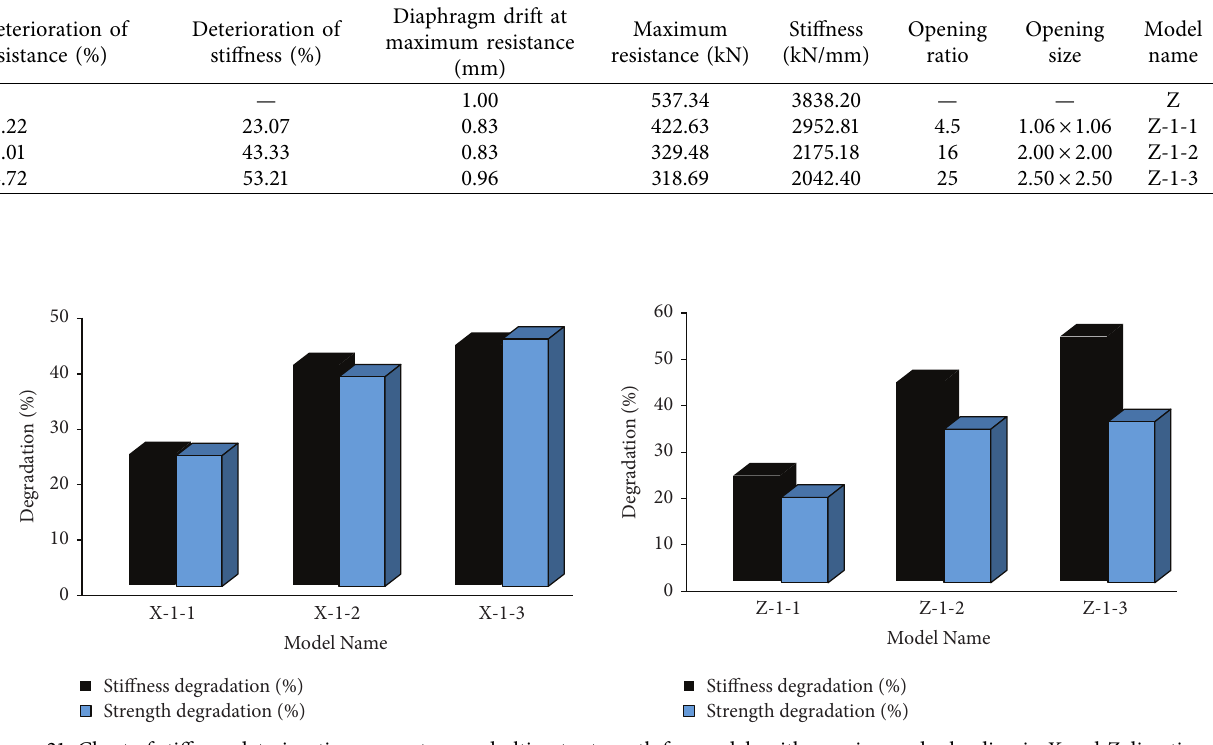
Figure 21: Chart of stiffness deteriorating percentage and ultimate strength for models with opening under loading in X and Z directions.